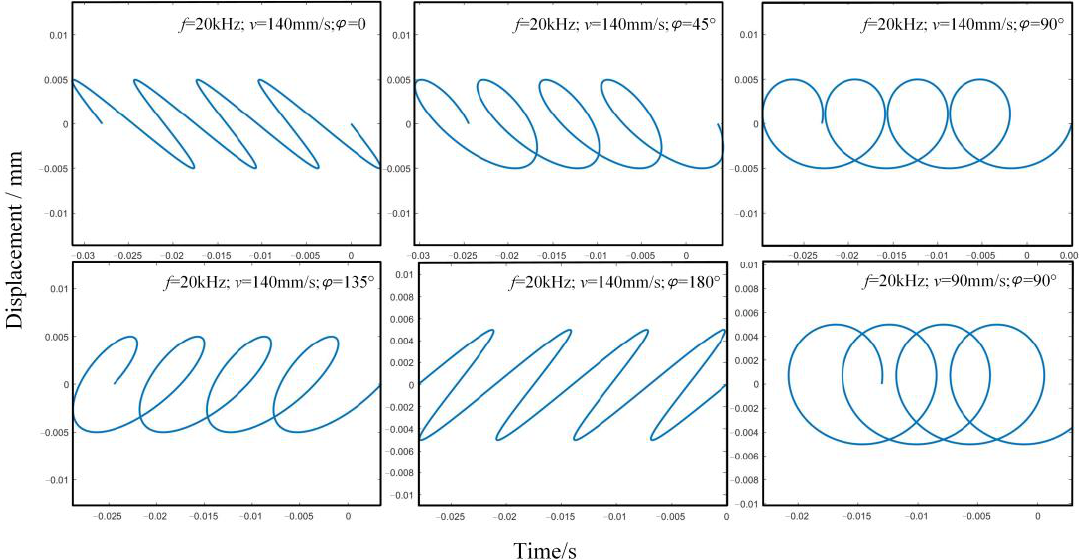
Figure 3. Variation of cutting trajectory under different parameters.